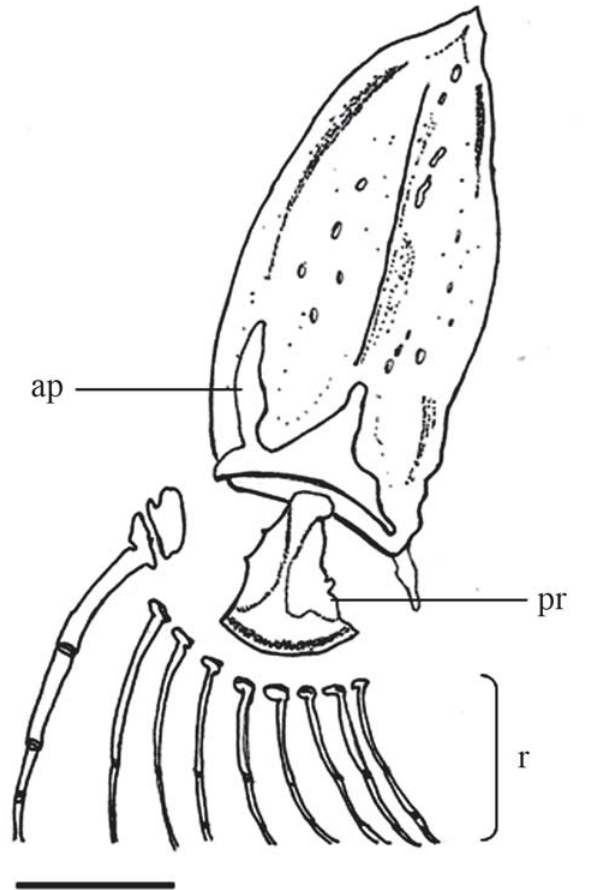
Fig. 6. Ventral view of the right pectoral girdle and fin of Trichomycterus uisae . CAC-CDMB 90, 41.1 mm SL. ap: ante- rior process; pr: pectoral radial; r: rays. Scale bar = 1